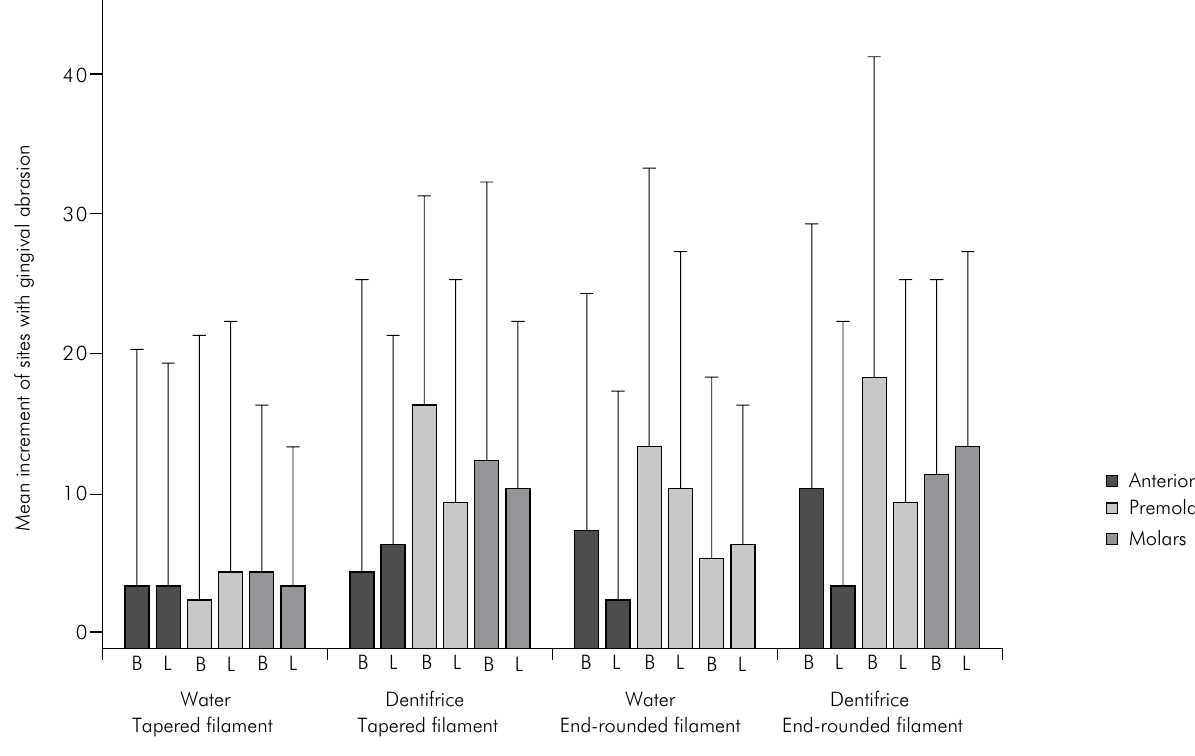
Figure 3. Mean percentage increase (Δ ± SD) in the number of sites with gingival abrasion according to tooth type and site (B: buccal site, L: lingual